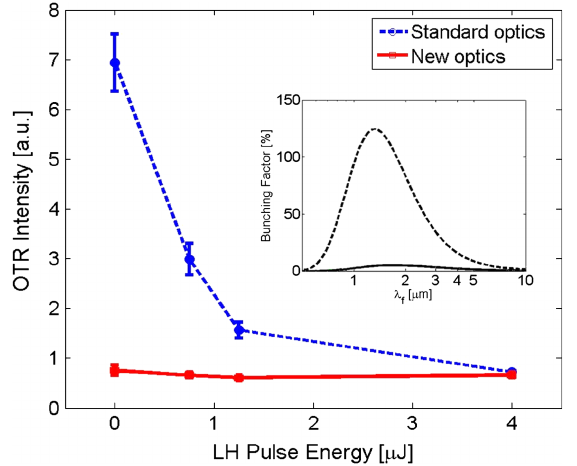
FIG. 8. OTR intensity measured at the end of the FERMI spreader vs LH pulse energy, for the standard (blue dashed) and the new optics configuration (red solid). Error bars are the rms fluctuation of the OTR signal over 500 consecutive shots. In the inset: bunching factor calculated at the end of the linac-plus- spreader beam line with LH off vs final (compressed) wavelength of modulation, for the spreader standard (dashed) and new optics (solid).